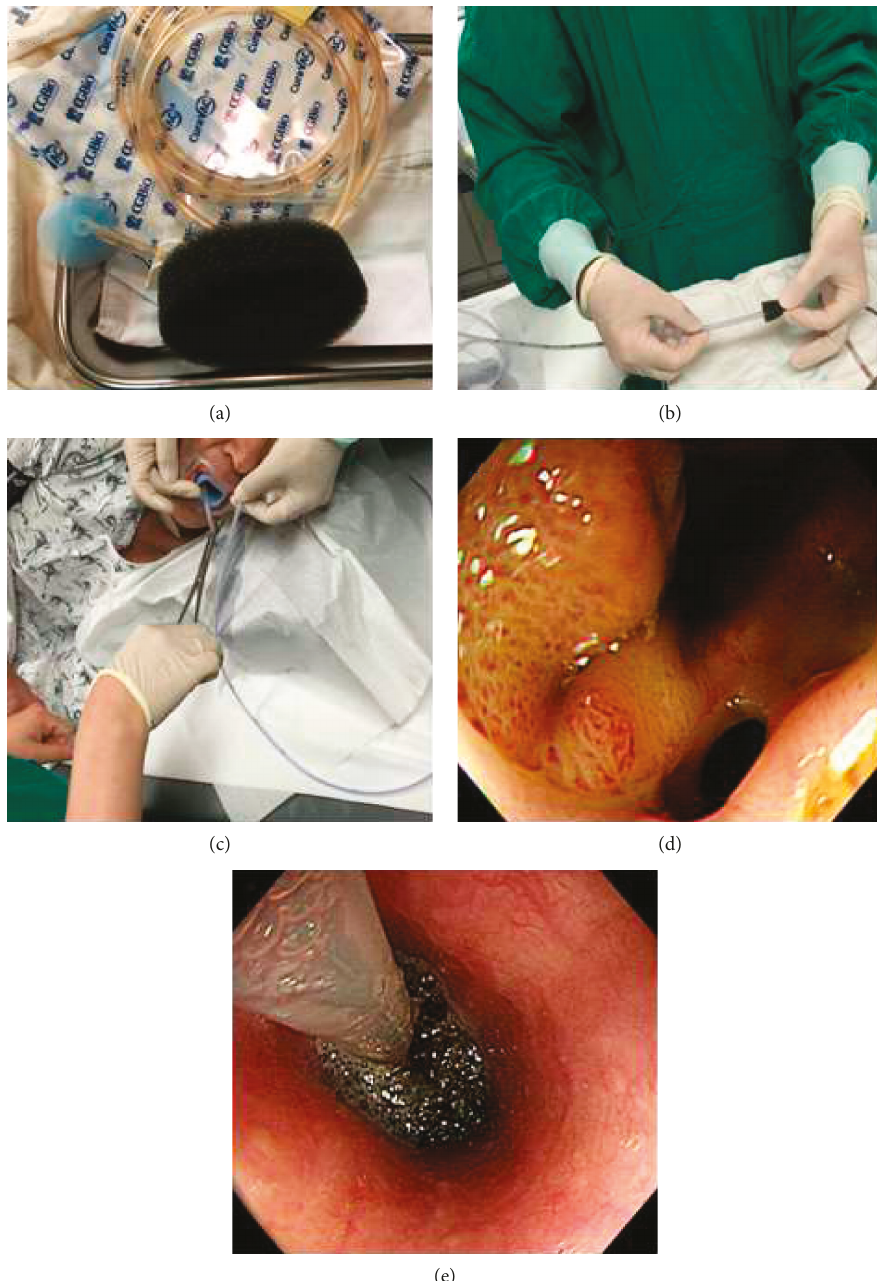
Figure 2: Steps in the endoscopic vacuum-assisted closure procedure. (a) The vacuum-assisted closure kit (CuraVAC; CGBio, Hwaseong, Korea) comprises a polyurethane sponge, adhesive drapes, and connector tubing. (b) A nasogastric tube with a polyurethane sponge head. The form and size of the sponge is similar to those of the anastomotic leakage. (c) A pulled-out nasogastric tube is connected to a polyurethane sponge. (d) Anastomotic leakage was noted on endoscopy (GIF-H290; Olympus, Tokyo, Japan). (e) The nasogastric tube embedded with a polyurethane sponge was placed in the anastomotic leakage